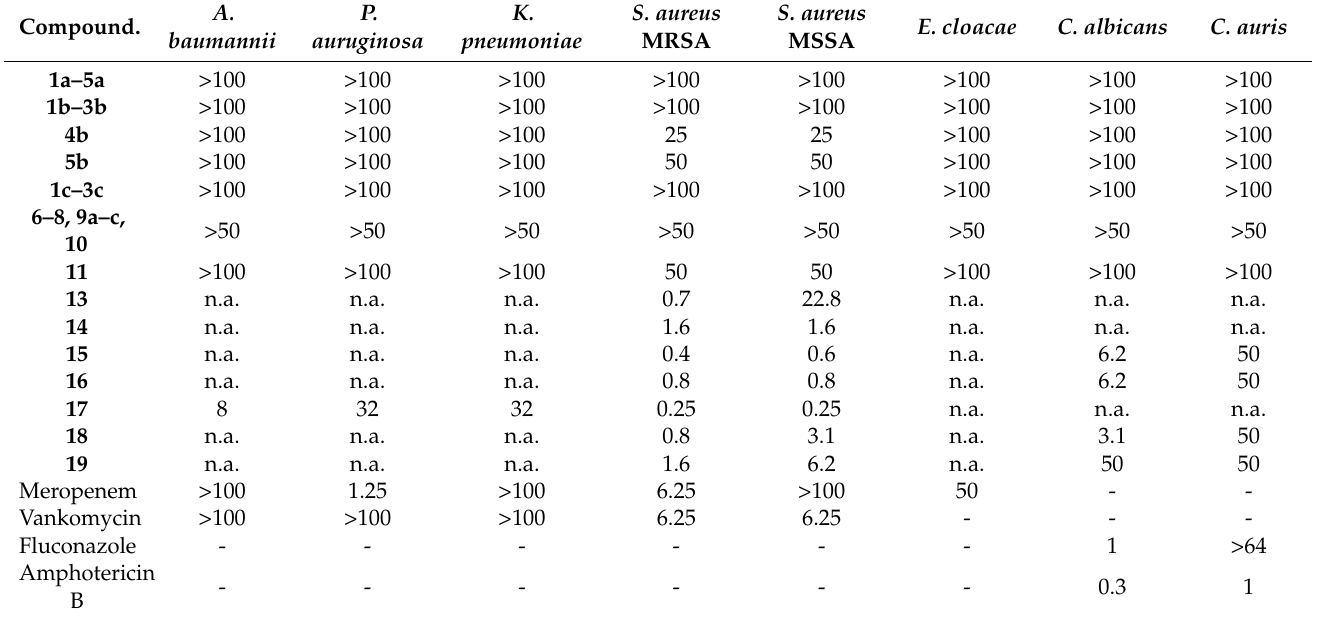
Table 1. Antimicrobial activity, assessed by determining the minimal inhibitory concentrations (MIC, µ M, mean of n = 3 independent experiments) of different Re-bearing complexes.